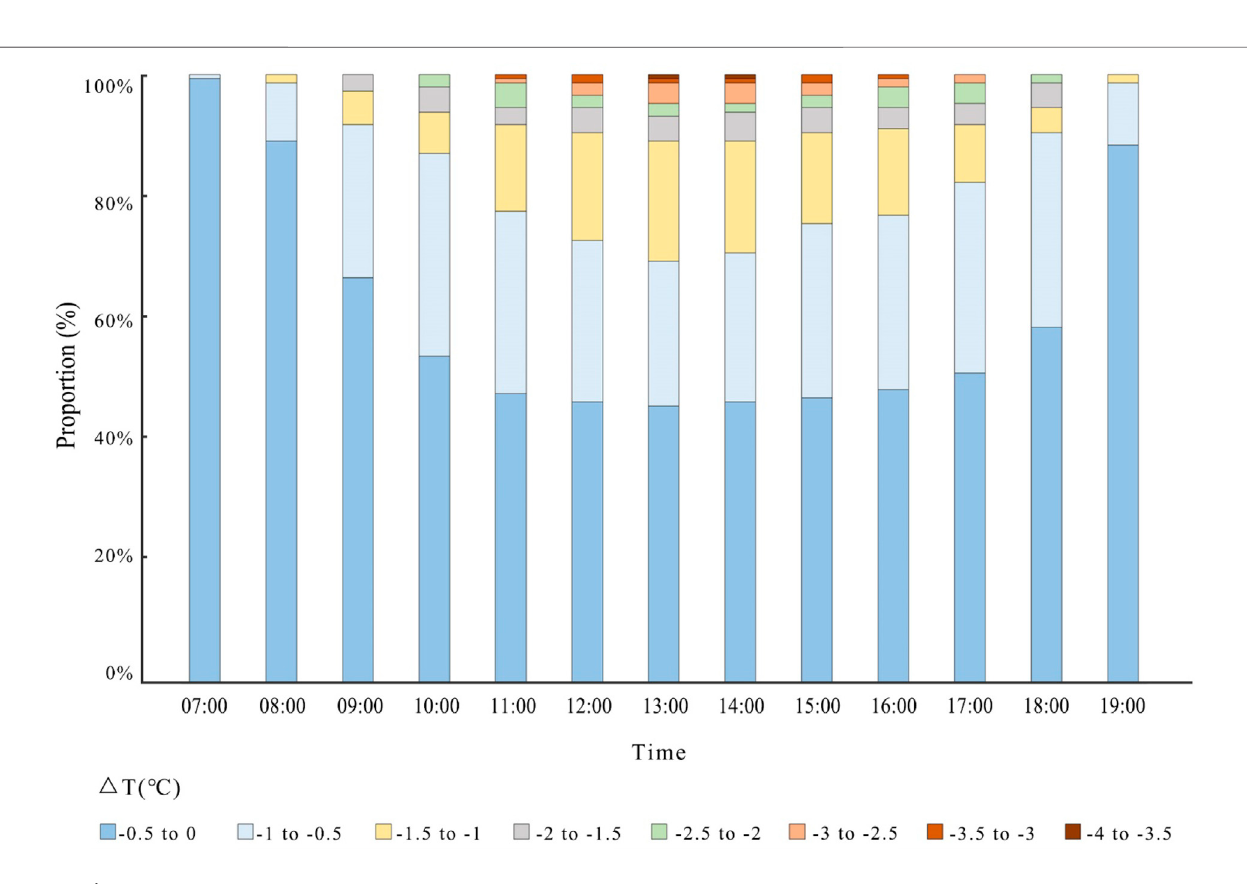
FIGURE 8 | Time-space proportion of water body cooling